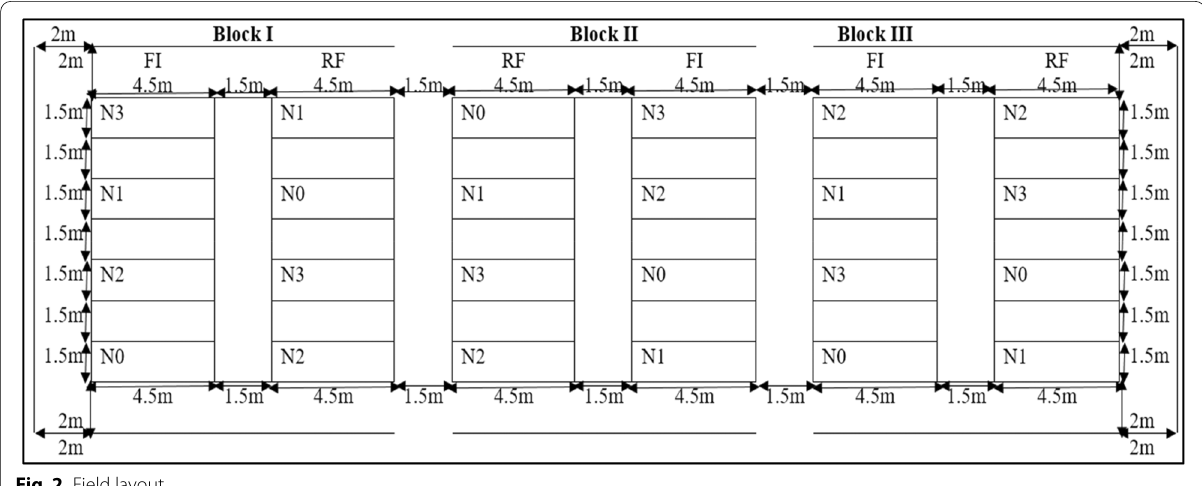
Table. 5 Monthly average of K